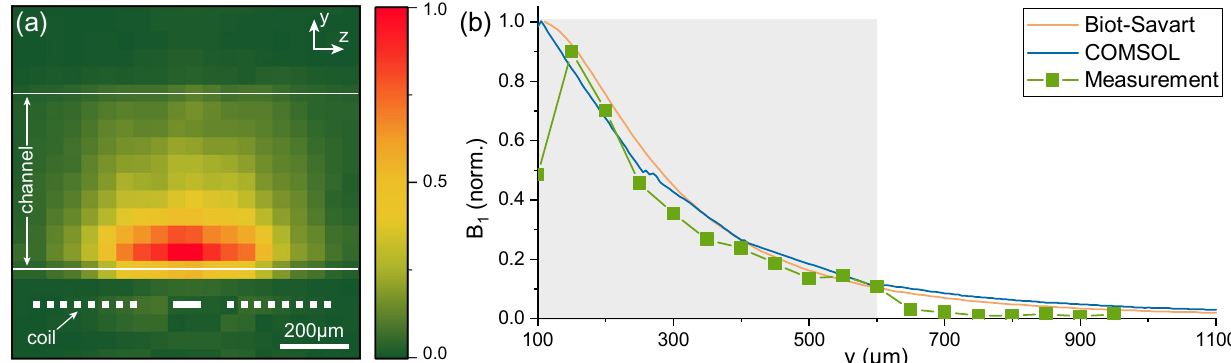
Figure 4. ( a ) Map of B 1 field (the component of the RF field being normal to B 0 ) generated by the coil at the sample region extracted from the MRI experiments. ( b ) Measured B 1 field, generated by the coil at its axis, is in good agreement with the simulation results and analytical expression derived from Biot–Savart formula (Eq. S1). The MRI results are valid just within the sample volume (indicated with the gray rectangle). The 0 µ m is a measurement error because of partial sample at the boundary voxels, as shown in mismatch at y = ( a